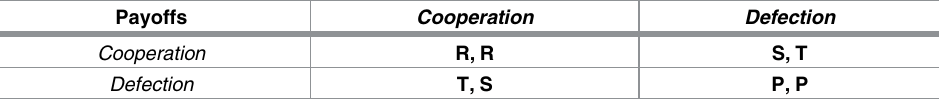
Table 1. Prisoner’s Dilemma payoffs.